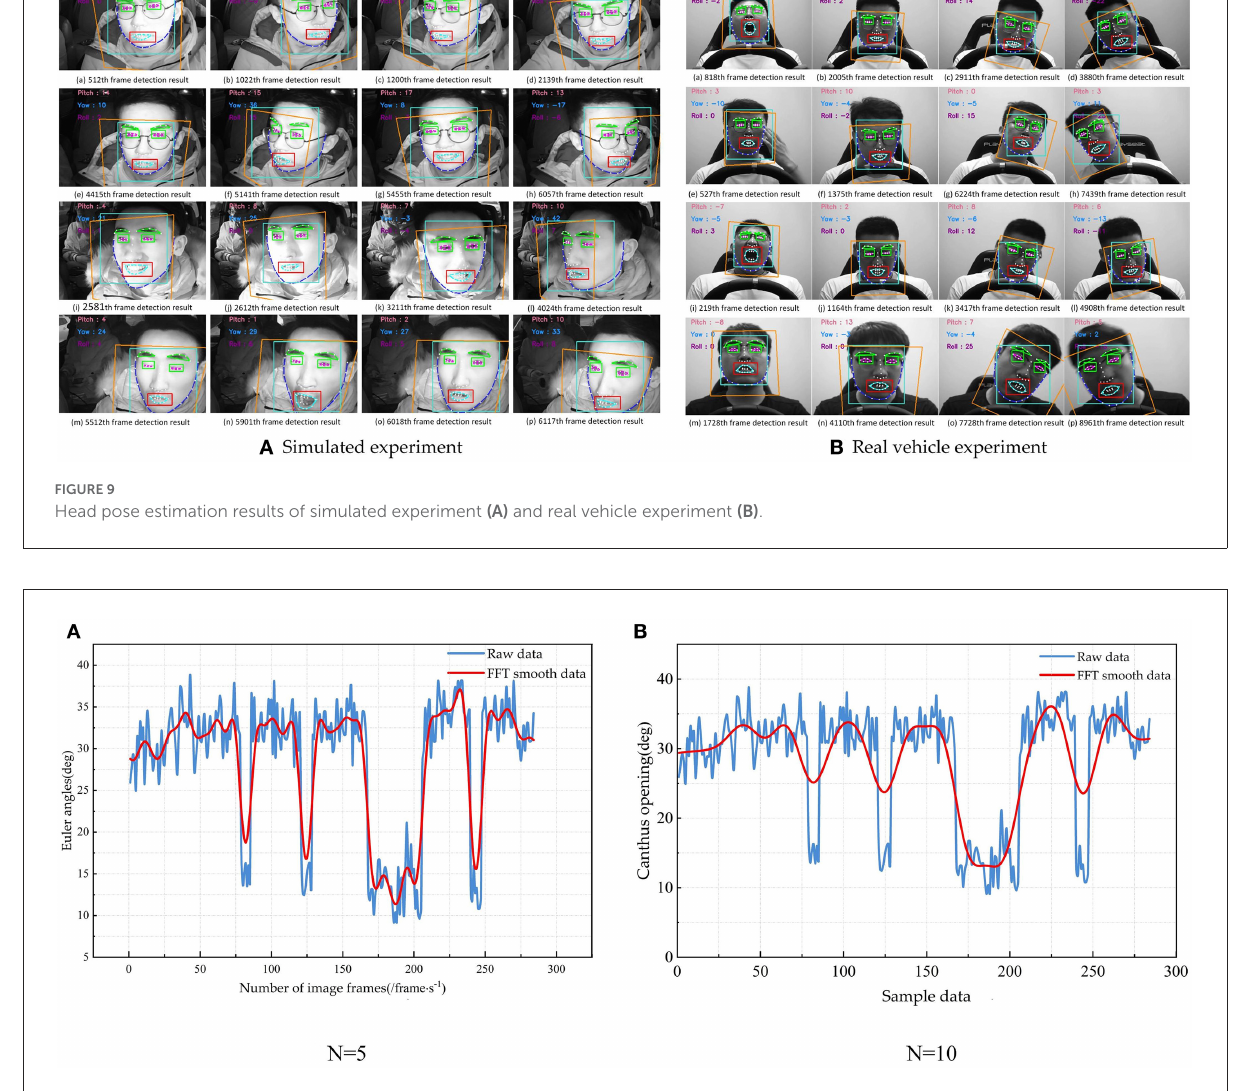
FIGURE10 Filtering results—FFT with filter windows of 5 (A) and 10 (B) .